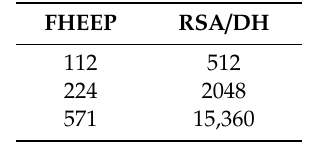
Table 1. Showing a key comparison of ECC, RSA, and DH.